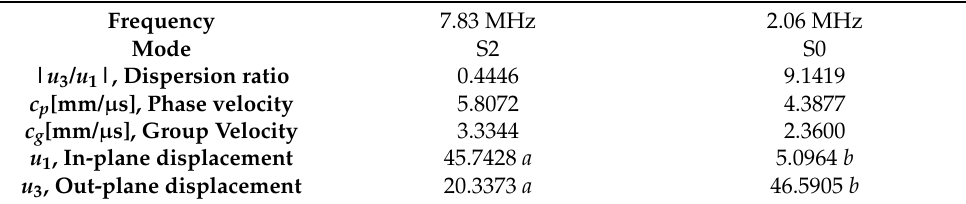
Table 1. Primary wave information.